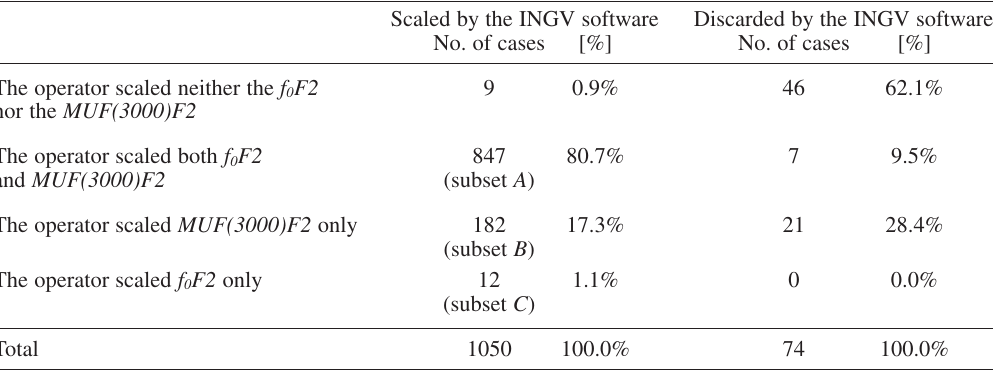
Scaled by the INGV software Discarded by the INGV software No. of cases [%]